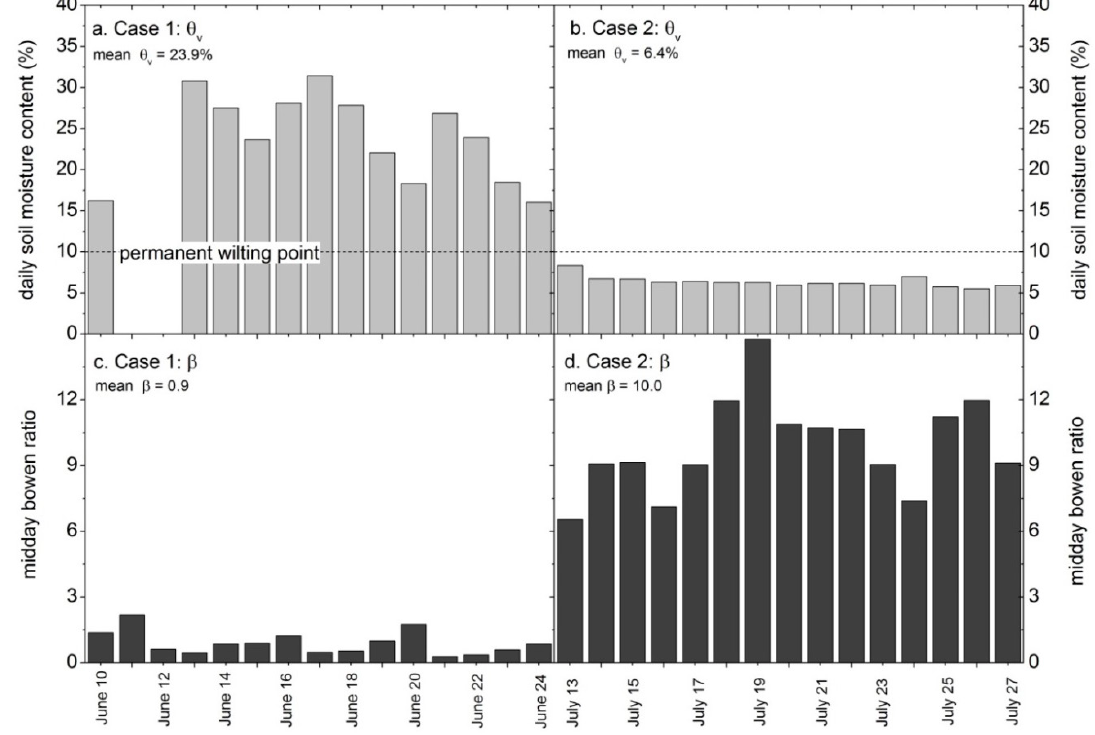
Figure 4. Mean daily soil moisture content measurements in ( a ) June 2011/Case 1 and ( b ) July 2011/Case 2. Mean midday Bowen ratio (β) measurements from the surface flux tower are also plotted for ( c ) June 2011/Case 1 and ( d ) July 2011/Case 2. The permanent wilting point is for a well-drained Kirkland